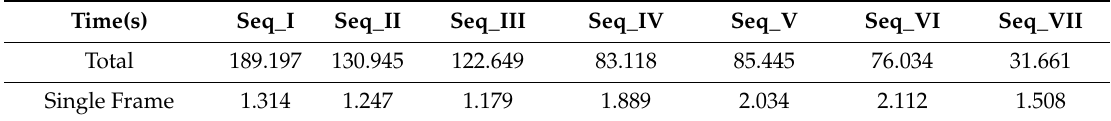
Table 4. The processing time of each sequence.